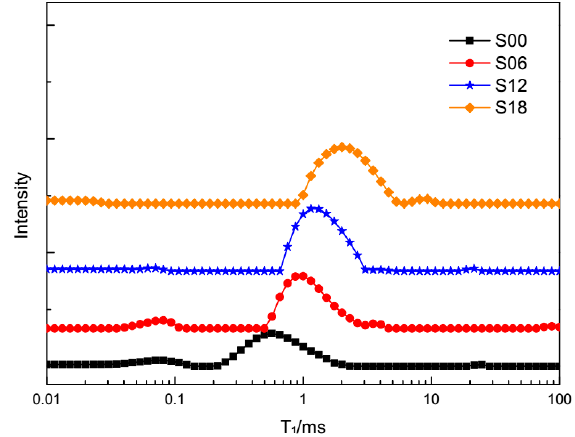
Figure 4. T 1 relaxometry of different cement pastes at 605 min.